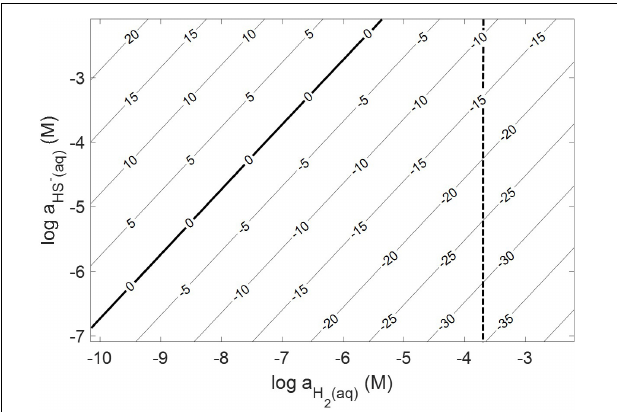
FIGURE 1 | Gibb’s free energy calculated for abiotic pyrite (FeS 2 ) reduction to pyrrhotite (Fe 1 - x S) and HS - by H 2 at 38 ◦ C, an ionic strength of 0.05 M, and at a pH of 7.0. The vertical dashed line depicts the minimum H 2 concentration that abiotic FeS 2 reduction was detected experimentally (see Figure 2 ).